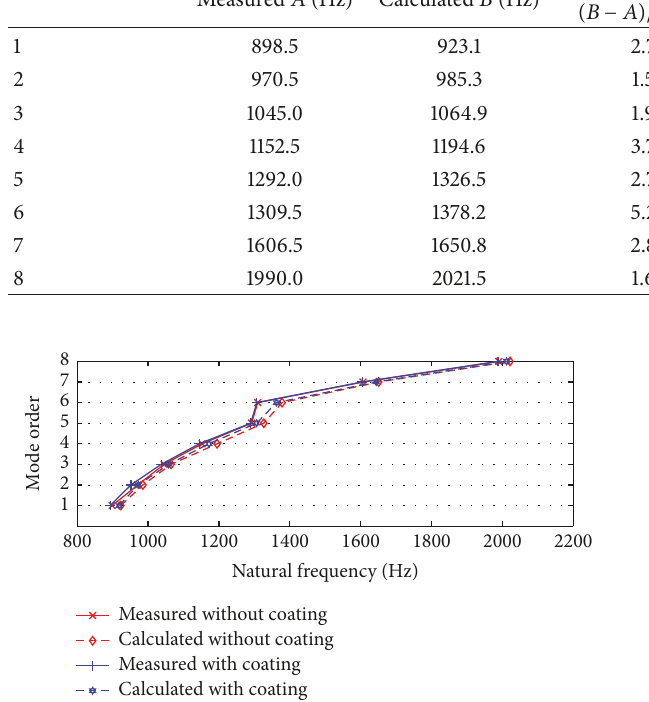
Table 12: The calculated natural frequencies and mode shapes of cantilever cylindrical shell with and without hard coating and their errors. Modal order